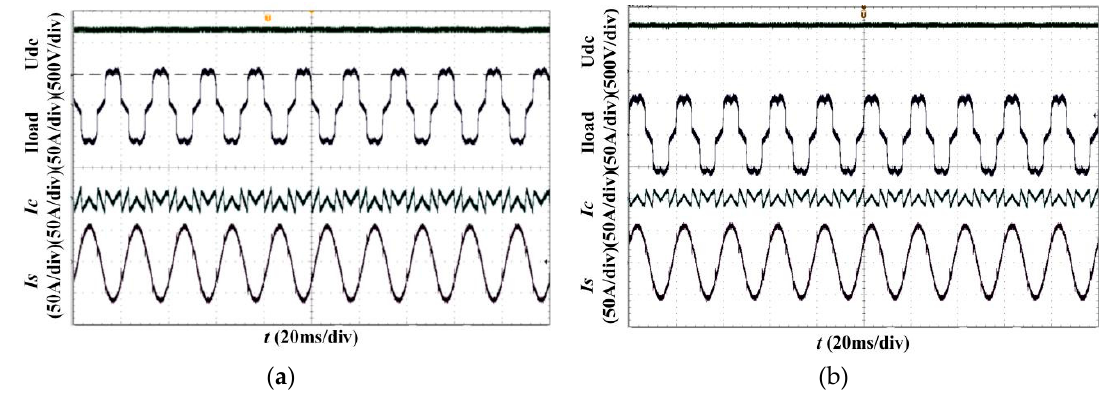
Figure 6. Voltage and current waveforms when U sn = 220 V, U dc-ref = 640 V and 660 V. ( a ) U dc-ref = 640 V; and ( b ) U dc-ref = 660 V.